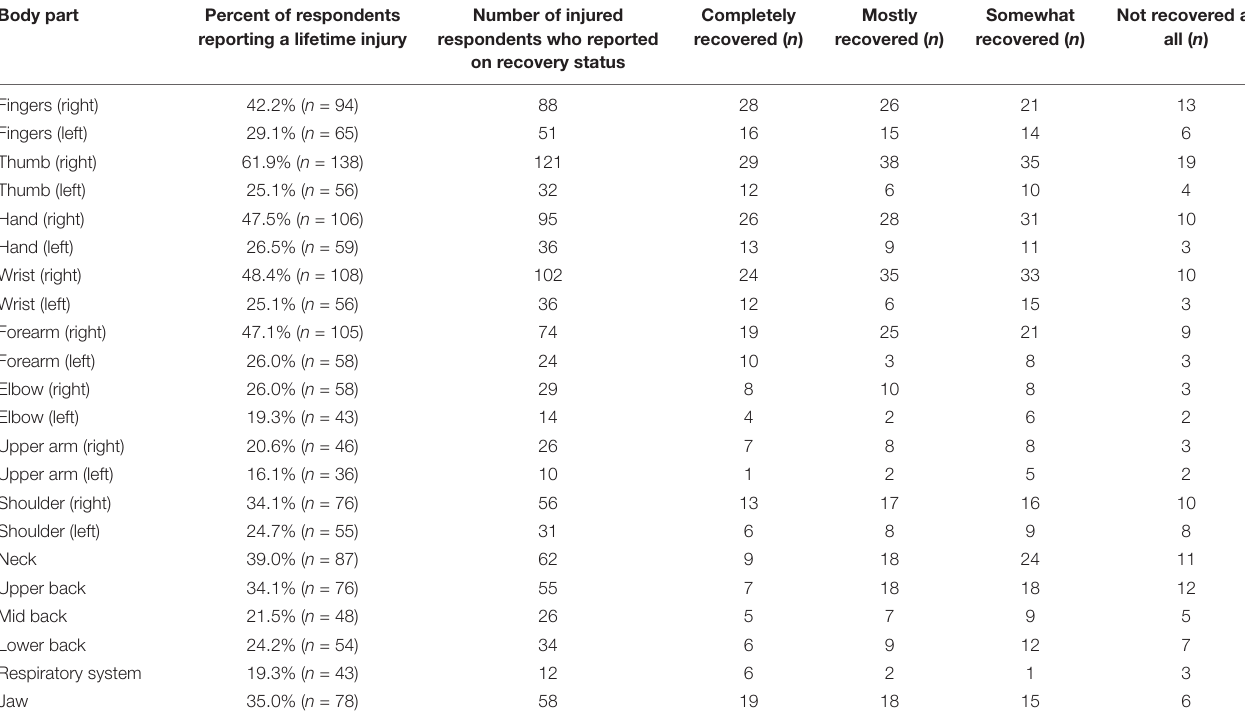
TABLE 1 | Number of respondents reporting recovery.